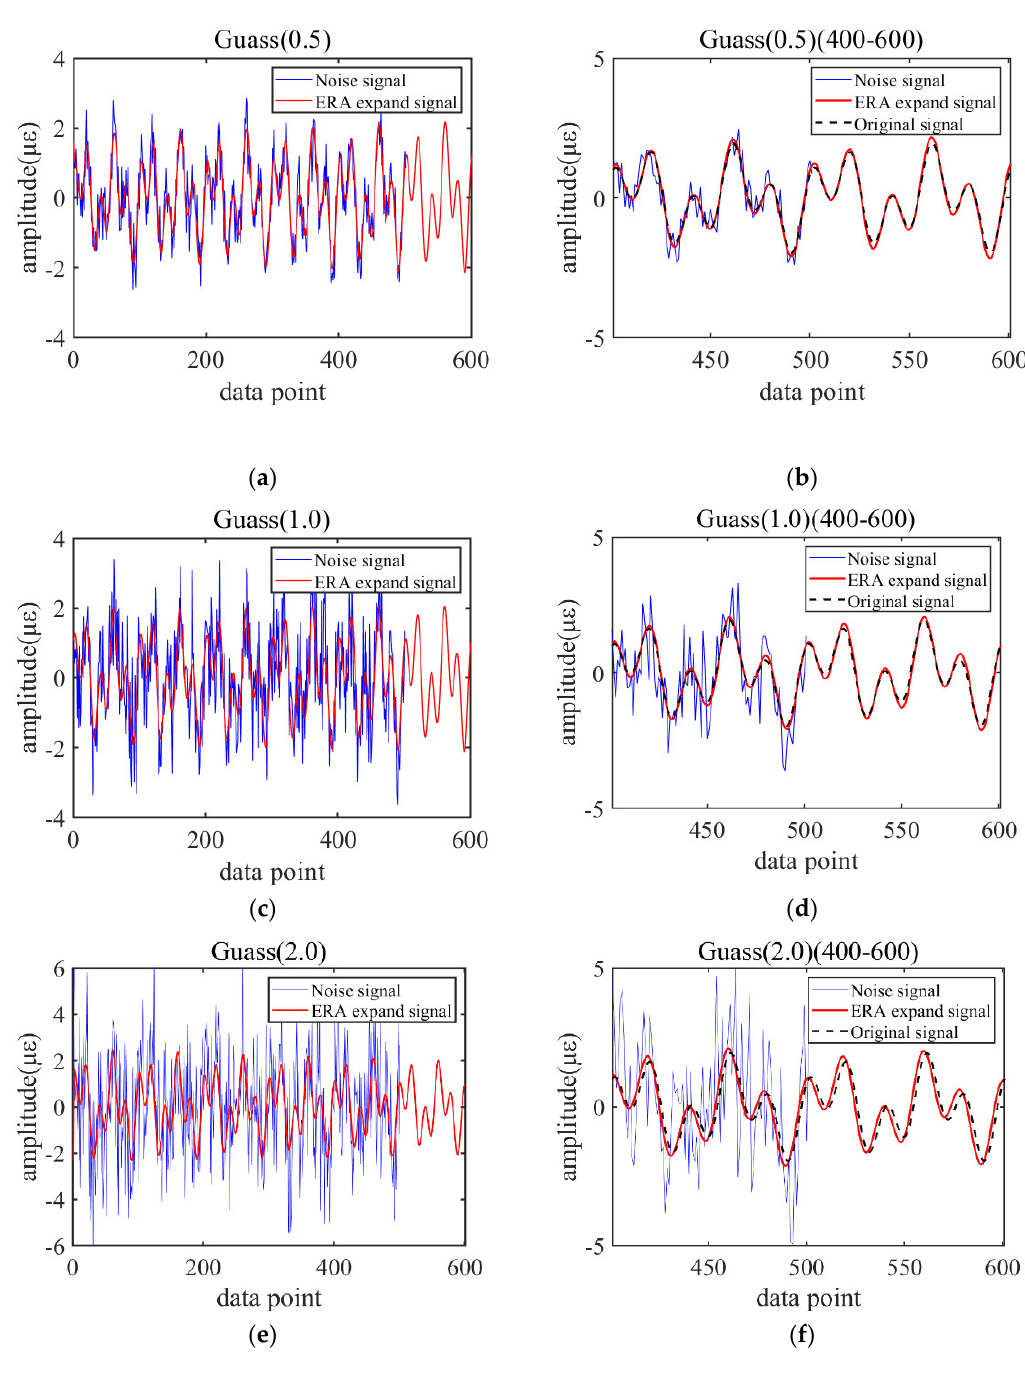
Figure 3. ( a , c , e ) Signal with standard deviation of 0.5, 1 and 2. ( b , d , f ) Extension part details. Mean square error (MSE) is used to measure the noise reduction effect; the results are shown in Table 1. The method is effective for signals with different noise levels. When the standard deviation of the noise increases, the delaying effect becomes worse because the added noise is close to the amplitude and frequency of the original signal; hence, the orig- inal signal is more easily confused with the noise.